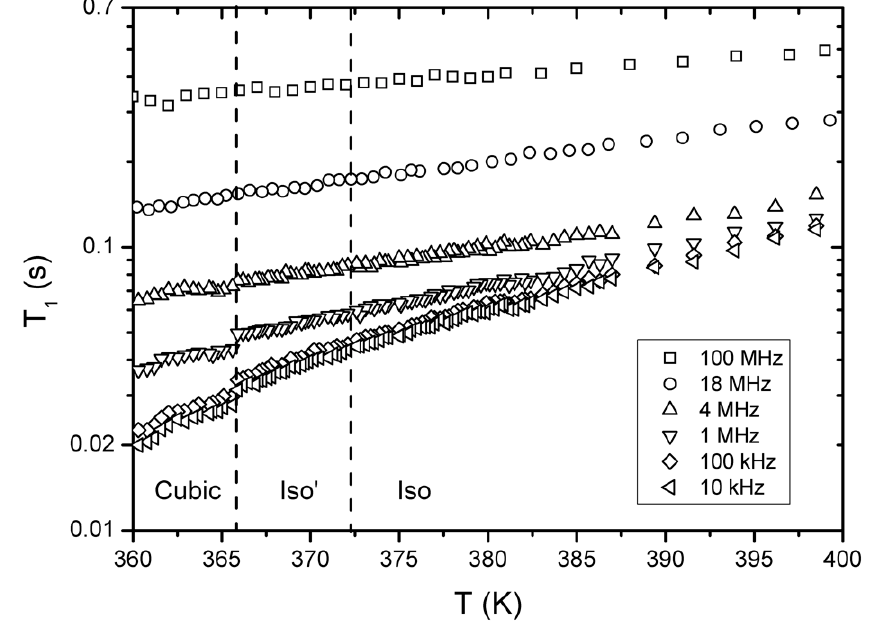
Figure 5. Temperature dependence of proton spin-lattice relaxation time of 9/2 RS/RS at some chosen Larmor frequencies. Vertical dashed lines indicate the phase transition temperatures.